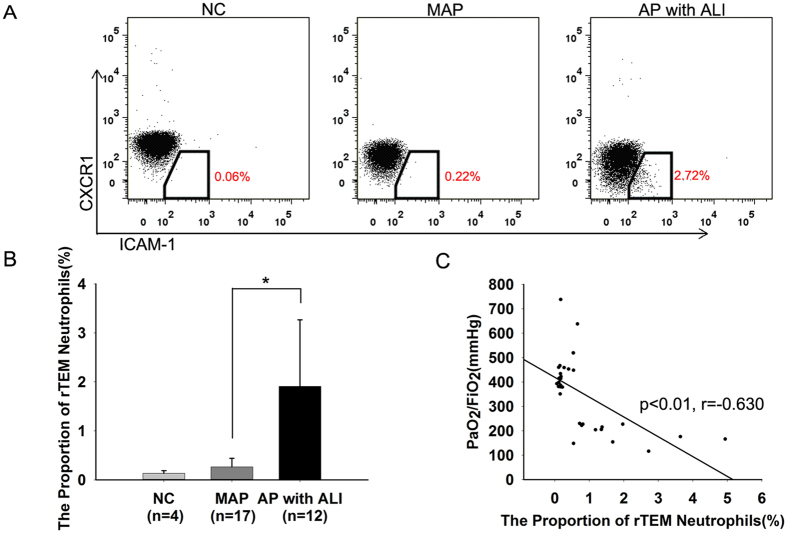
Reverse-migrated (rTEM) neutrophils are positively associated with lung injury in patients with acute pancreatitis (A) Human neutrophils were analyzed for ICAM-1 and CXCR1 expression by flow cytometry; examples of scatter plots of ICAM-1 and CXCR1 profiles are shown.The numbers in red demonstrate the greater percentage of ICAM-1highCXCR1low population (rTEM neutrophils) in patients with acute pancreatitis (AP) associated acute lung injury (ALI). (B) A comparison of the levels of rTEM neutrophils in healthy controls (NC, n = 4), MAP (mild acute pancreatitis, n = 17) and AP with ALI (n = 12) (*p < 0.01). (C) An increased level of rTEM neutrophils in the peripheral blood positively correlated with the decline of PaO2/FiO2 (r = −0.630, p < 0.01).